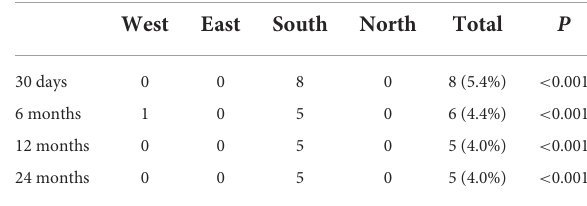
TABLE 6 Endovascular time mean ranks vs. reintervention in each period.